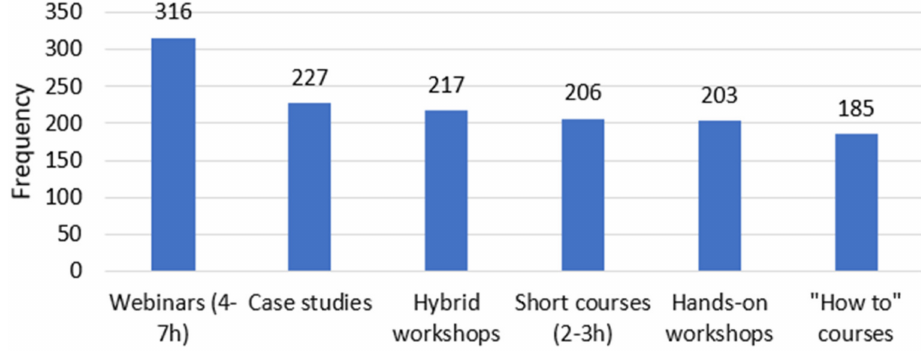
Figure 2. Preferred type of event by respondents.